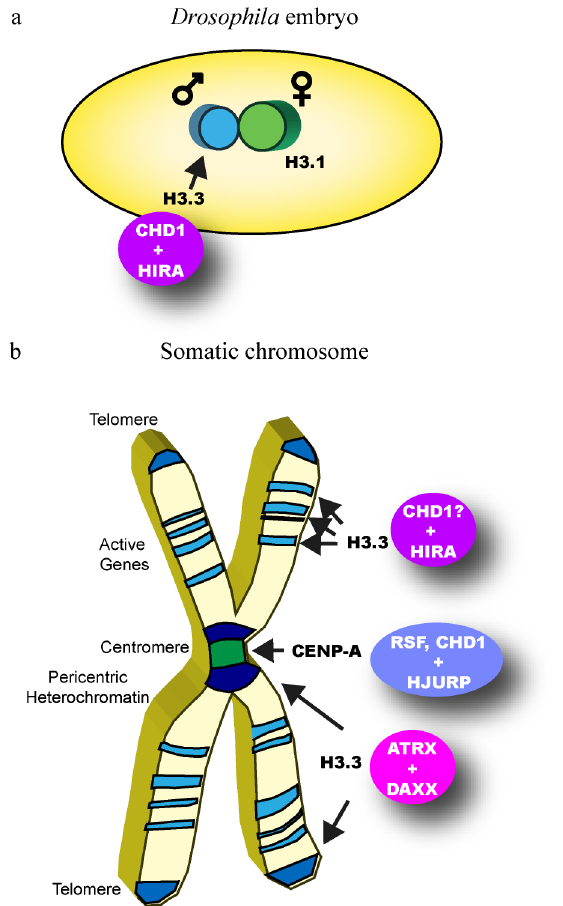
Figure 2. Replication-independent assembly of histone H3 variants. ( a ) The chromatin remodeler CHD1 cooperates with the H3.3-specific histone chaperone HIRA to incorporate H3.3 into the paternal pronucleus at fertilization in Drosophila embryos. The maternal pronucleus does not require chromatin reorganization and contains predominantly H3.1. ( b ) Different chromatin remodeling complexes in conjunction with specific histone chaperones incorporate H3.3 and CENP-A at distinct chromosomal sites. Dark blue shading indicates H3.3 incorporation into telomeric and pericentric heterochromatin, respectively. Lighter blue shading indicates H3.3 assembly at genic locations. Green shading denotes CENP-A incorporation into chromatin at the